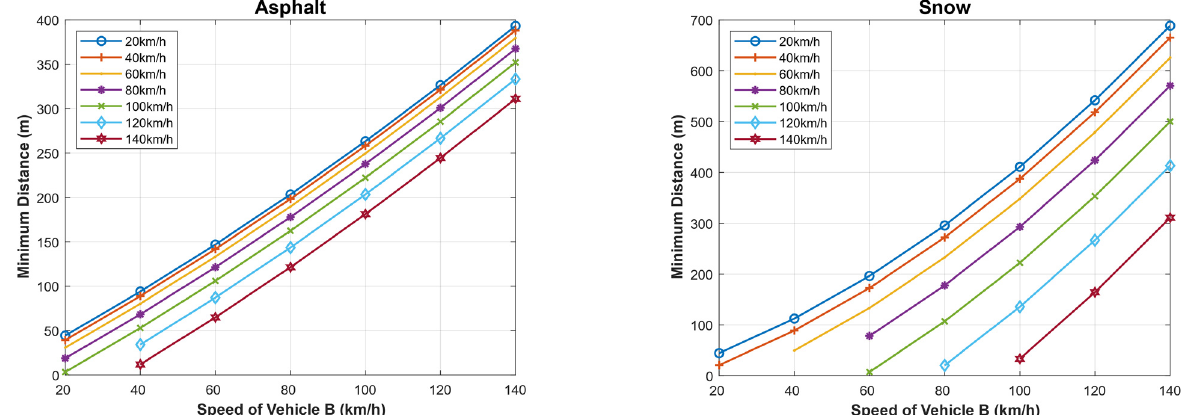
Figure 17. Foggy weather: minimum safe driving distance for different speeds of both the following and the followed vehicle in the case when the weather is clear, assuming the driver reaction time is 8 s for dry asphalt and snowy roads.